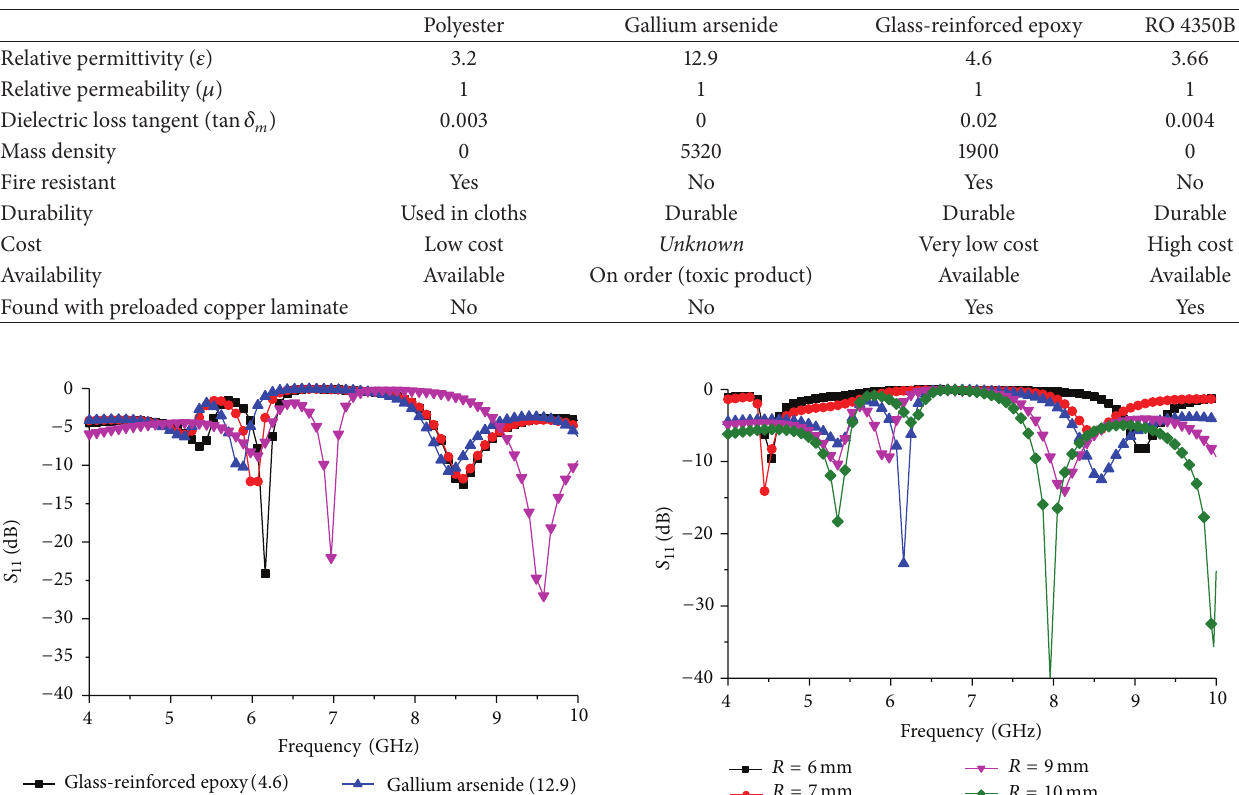
Figure 5: (a) Complementary patch and (b) complementary ground plane. Table 1: Characteristics of polyester, gallium arsenide, glass-reinforced epoxy, and rogers RO 4350B (from HFSS “high frequency structural simulator”).